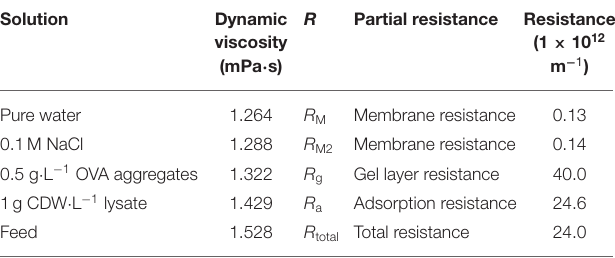
TABLE 3 | Partial resistances determined by resistance-in-series analysis.